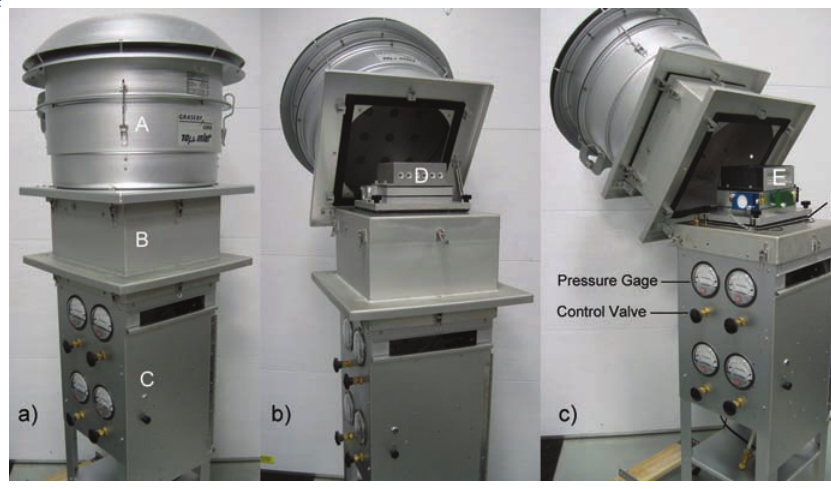
Trichotomous Sampler. Fig. 6 Photos of PM 1.0/2.5/10 a) Assembled sampler; b) 2.5 µm HVVI; c) 1.0 µm HVVI A-PM10 inlet; B-Intermediate chamber; C-Base; D-2.5 µm HVVI; E-1.0 µm HVVI;